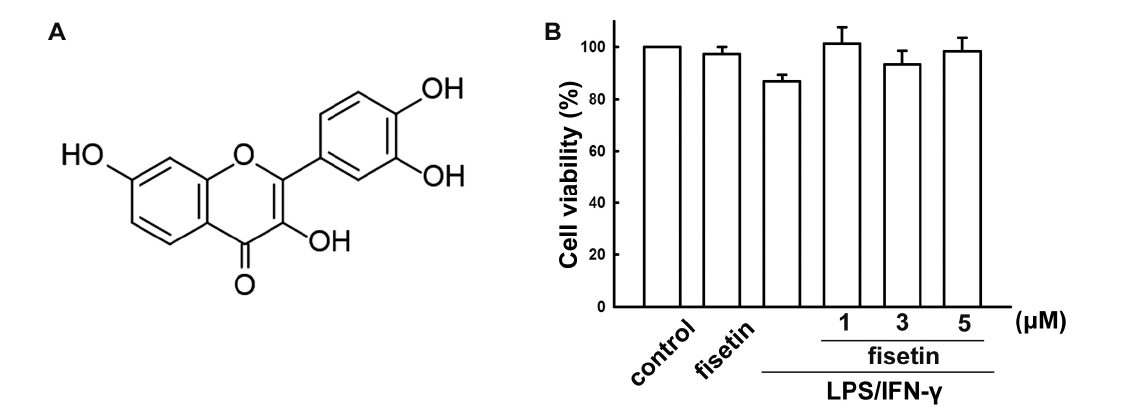
Figure 1. Effect of fisetin on microglial activation. ( A ) Chemical structure of fisetin. ( B ) Cell viability following fisetin treatment in BV-2 microglia. Cells were incubated with (10 ng/mL) plus IFN- γ (10 ng/mL) for 24 h, and cell viability was measured by the